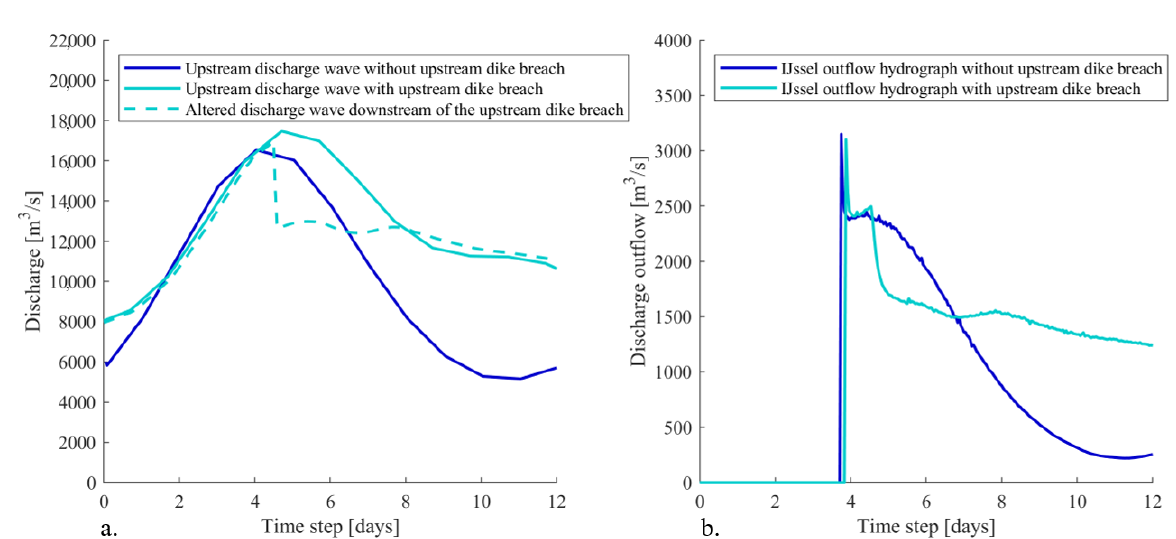
Figure 6. ( a ) The upstream instream discharge waves used as boundary condition of the hydraulic model and as input of the NARX networks (solid lines) and corresponding altered instream discharge wave if a dike breach occurs at the most upstream breach location just downstream of the dike breach (dashed line). ( b ) Corresponding outflow hydrographs at the IJssel dike breach location (i) if no dike breach occurs at the most upstream dike breach location and (ii) if a dike breach occurs at the most upstream dike breach location. For the locations of the most upstream and IJssel river dike breach locations, please see Figure